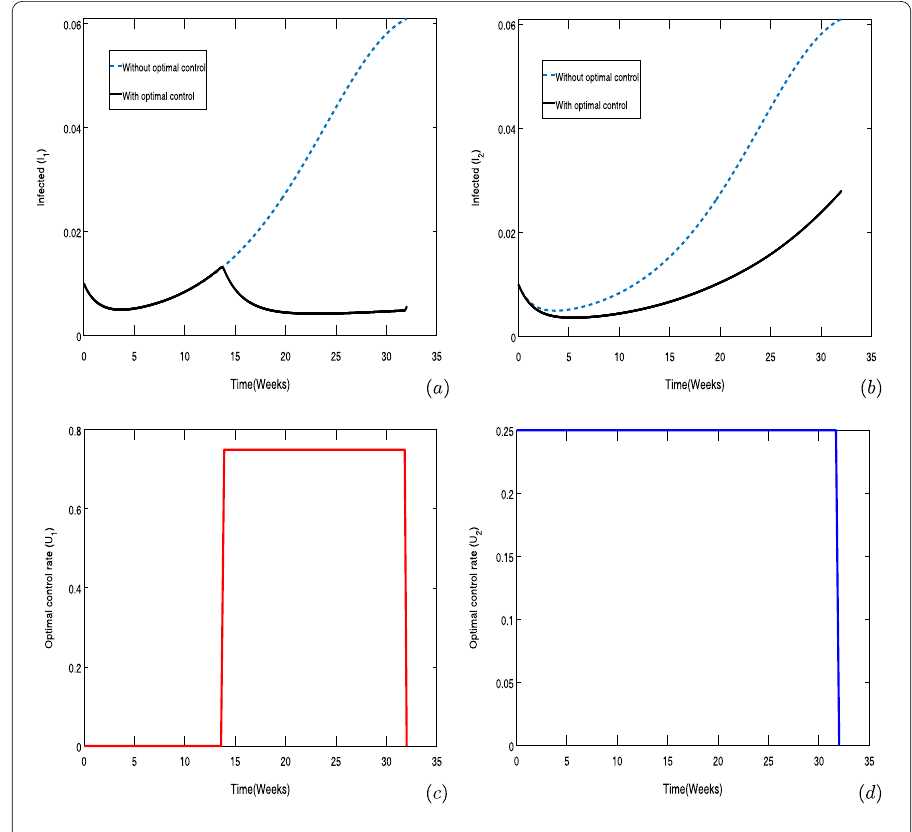
Figure 2 Time series plots showing the effects of optimal control on the ( a ) infected individuals for patch 1 ( I 1 ), ( b ) infected individuals for patch 2 ( I 2 ); also the optimal control graphs for the two controls, ( c ) educational campaigns for patch 1 and ( d ) educational campaigns for patch